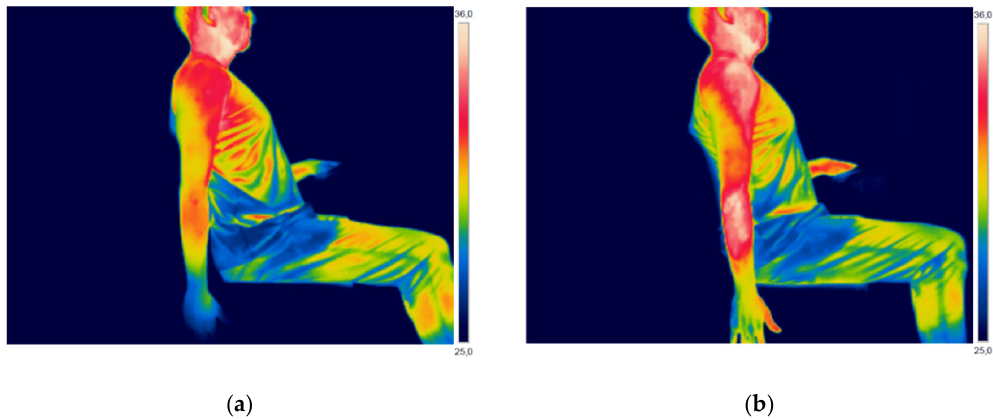
Figure 3. Thermographic image of a male participant: ( a ) before performing the high-risk repetitive task; and, ( b ) after performing the high-risk repetitive task.